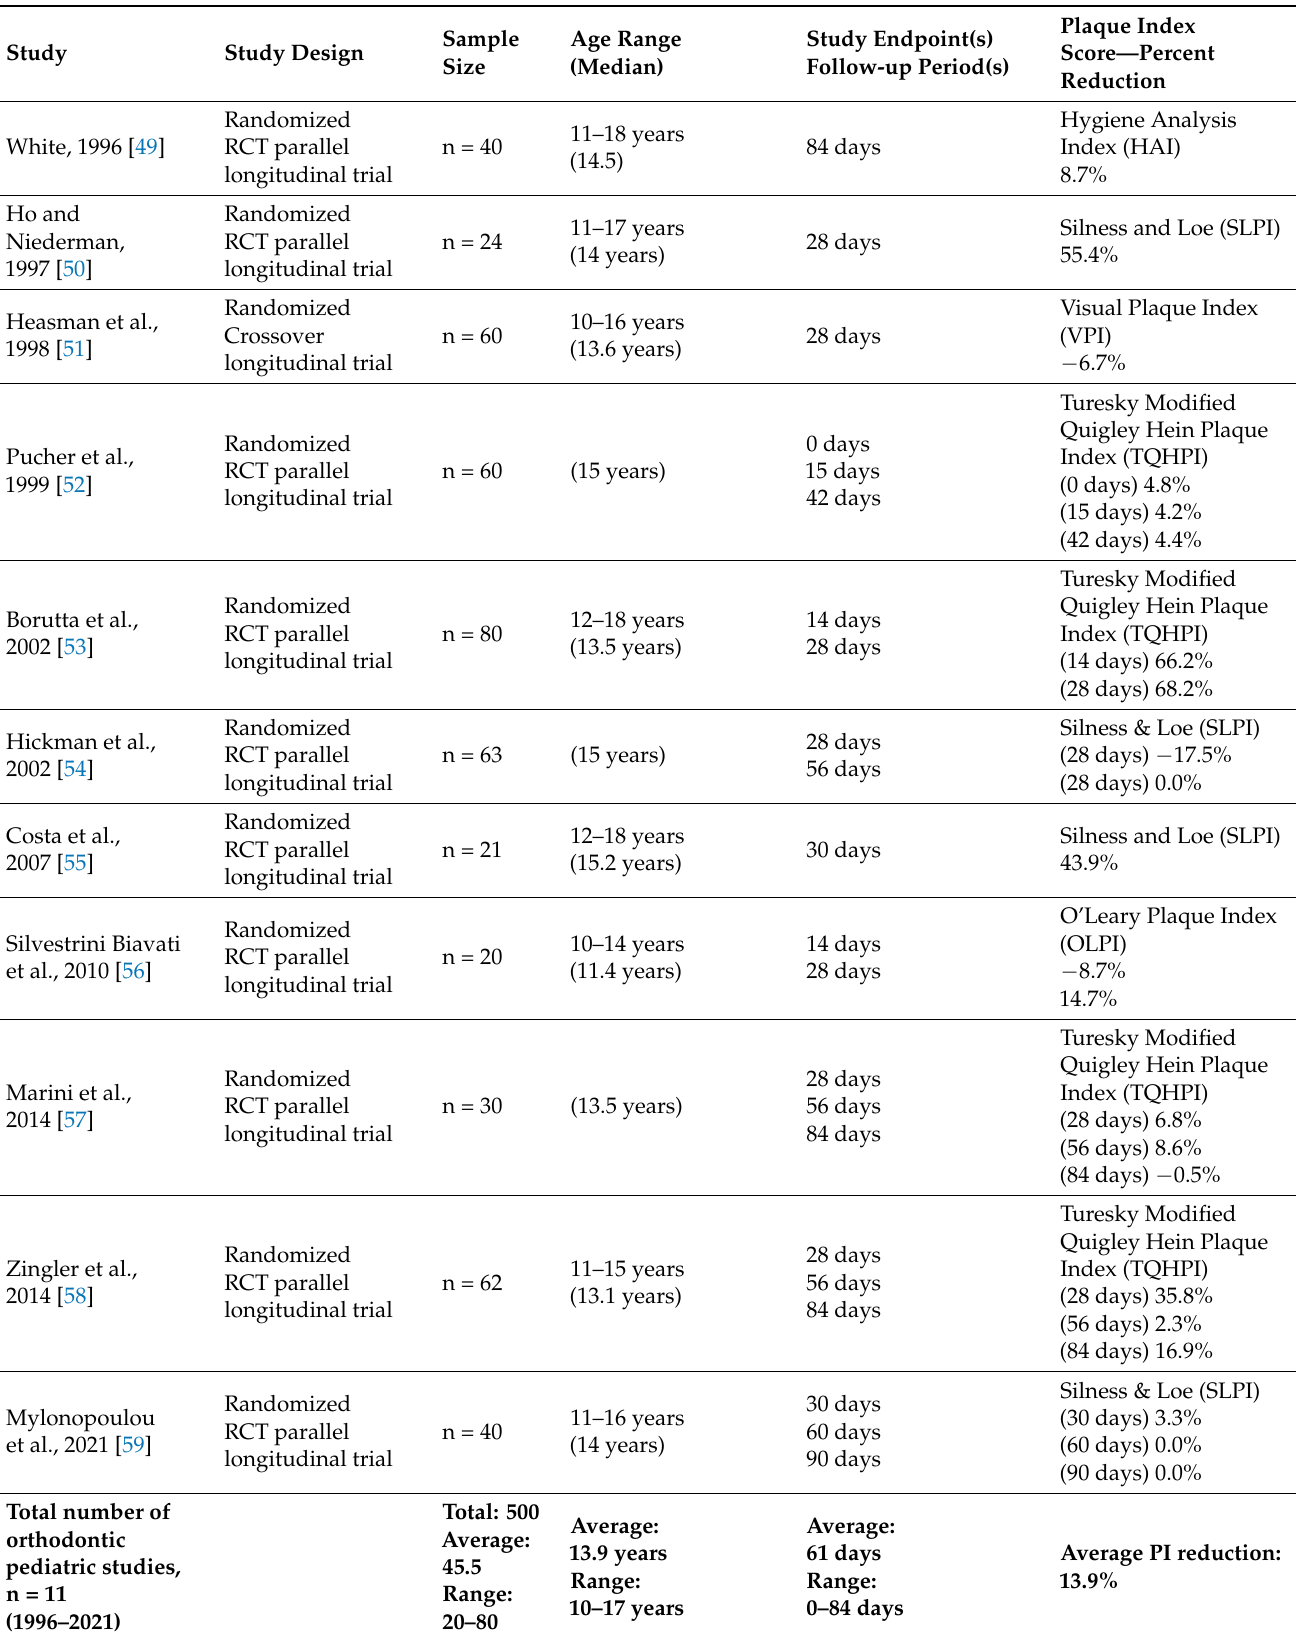
Table 2. Characteristics of pediatric, orthodontic inclusion